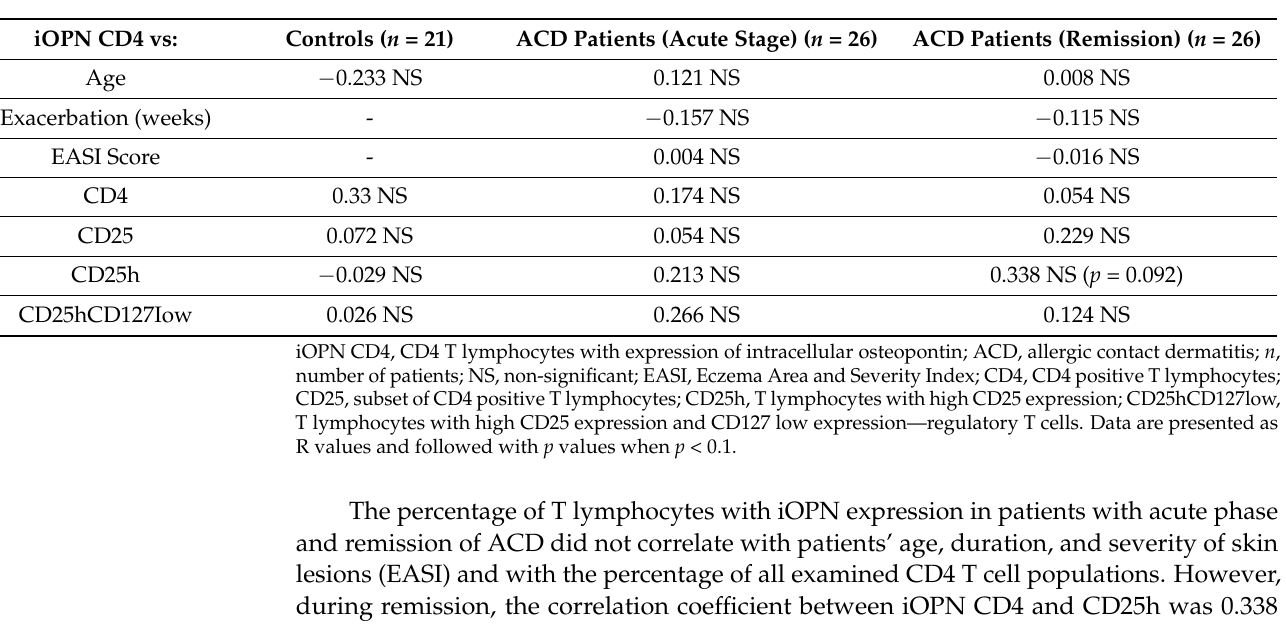
Table 2. Correlation between iOPN CD4 cells percentage with selected variables in patients with ACD.